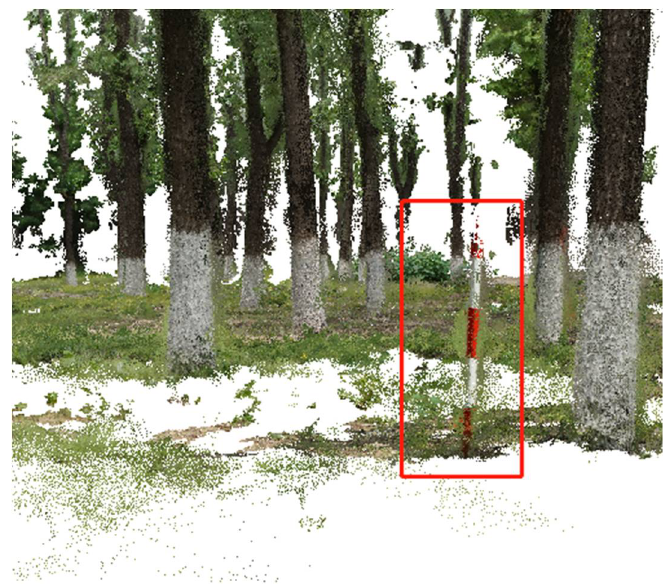
Figure 2. A target pole in sample plot.